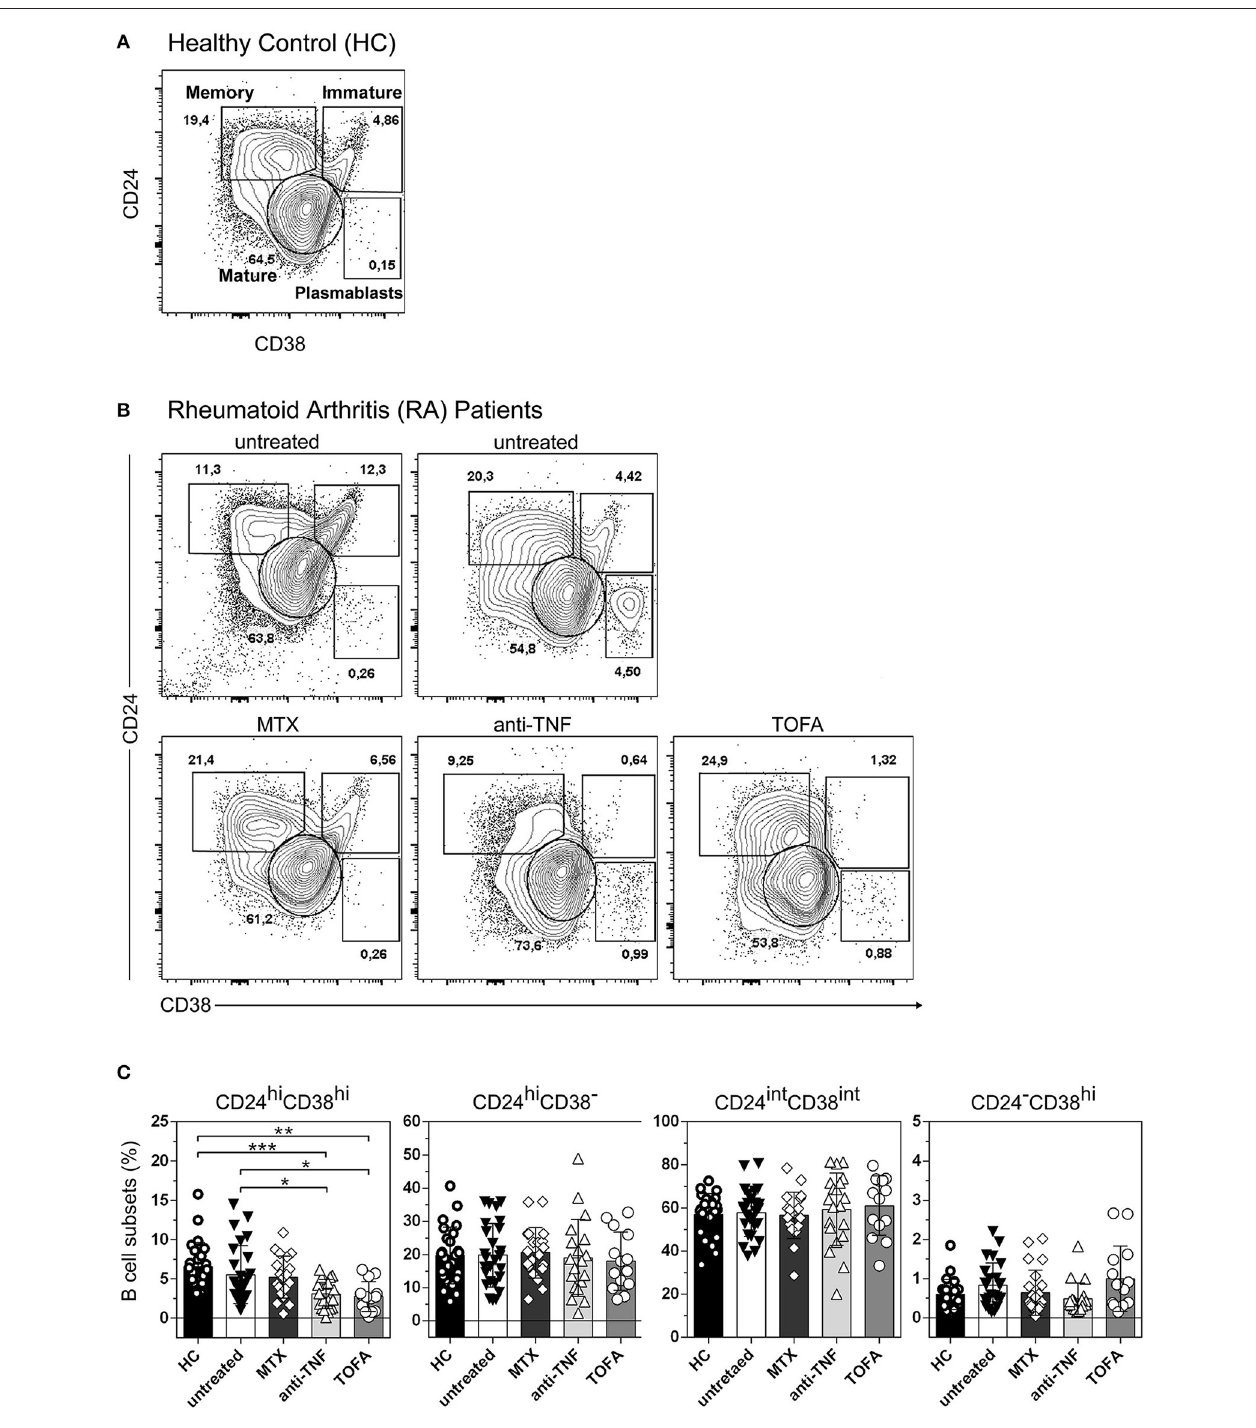
FIGURE 1 | Changes in peripheral blood B cell subsets in RA patients following different treatments. Representative dot plot with gating strategies for B cell subsets: CD19 + CD24 hi CD38 hi B cells (immature B cells), CD19 + CD24 int CD38 int B cells (mature B cells), CD19 + CD24 hi CD38 − B cells (primarily memory B cells) and plasmablasts (CD19 + CD24 − CD38 hi ) from (A) healthy controls (HC) and (B) untreated RA patients or RA patients treated with methotrexate (MTX), anti-TNF or Tofacitinib (TOFA). Flow cytometry analysis was performed on CD19 + B cells. (C) Bar charts show frequencies of immature (CD24 hi CD38 hi ), memory (CD24 hi CD38 − ), mature (CD24 int CD38 int ) and plasmablast (CD24 − CD38 hi ) CD19 + B cells in HC ( n = 25), untreated ( n = 26) or treated RA patients (MTX, n = 20; anti-TNF, n = 20; TOFA, n = 14). Data are expressed as mean ± SEM. * p < 0.05, ** p < 0.01, *** p < 0.001. Kruskal-Wallis test with Dunn’s correction were used.